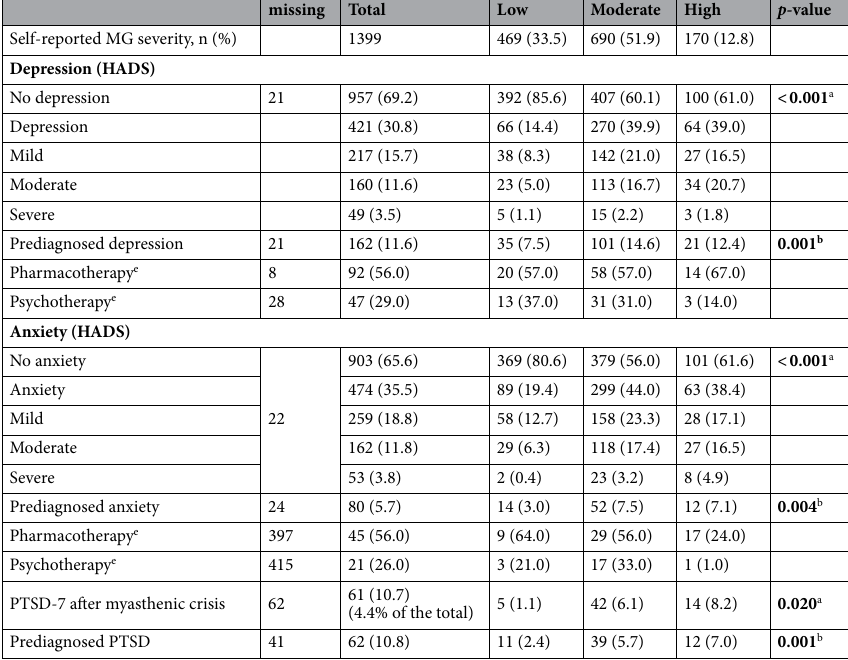
Table 2. Psychiatric comorbidities in MG patients. PTSD Posttraumatic stress disorder. P -values refer to overall group comparisons of patients with low, moderate and high MG severity. P -values < 0.05 are marked in bold numbers a Kruskal–Wallis-Test, b Chi-square test. e % of prediagnosed